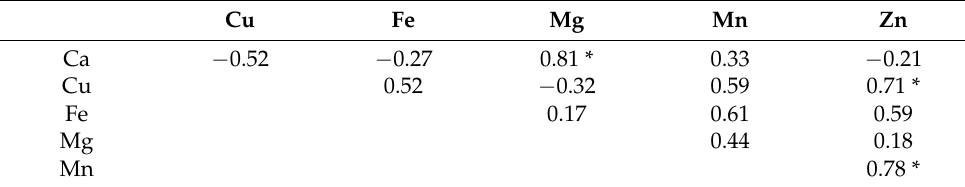
Table 6. The values of the correlation coefficients for the content of analytes in samples in early atheroma development stages. Statistically significant values are marked with an